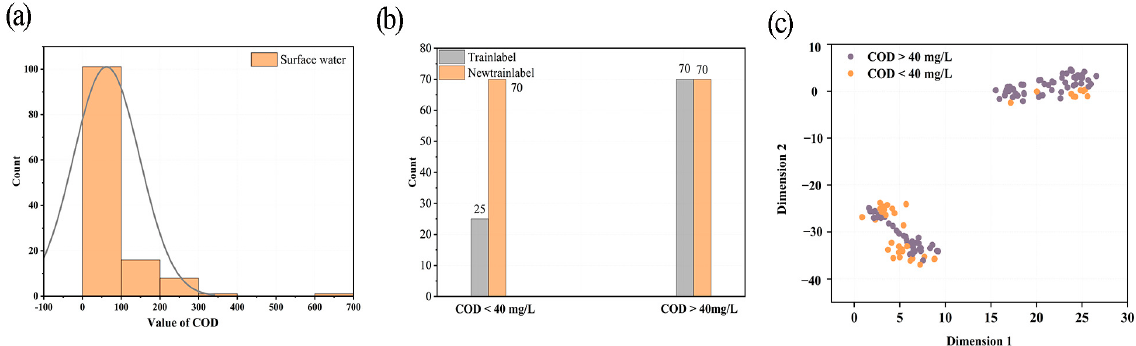
Figure 1. ( a ) Histogram of surface water COD value distribution, ( b ) distribution of training set samples before and after SMOTE expansion, ( c ) t − SNE visualization results plot.